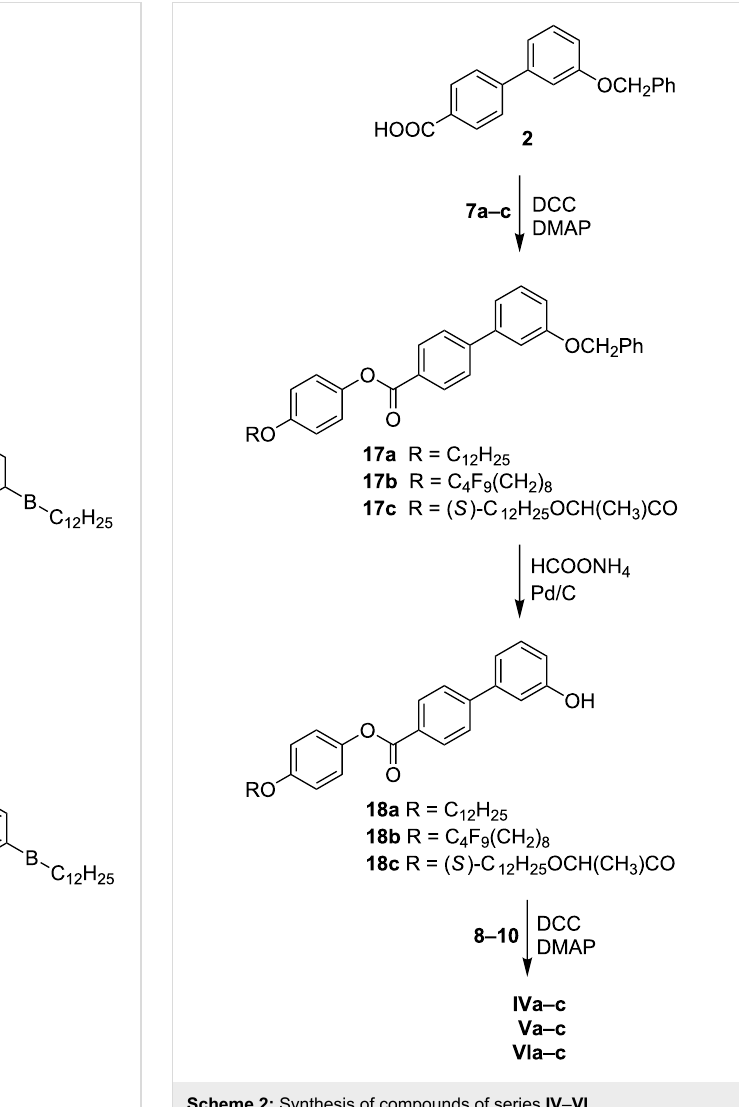
Scheme 2: Synthesis of compounds of series IV – VI